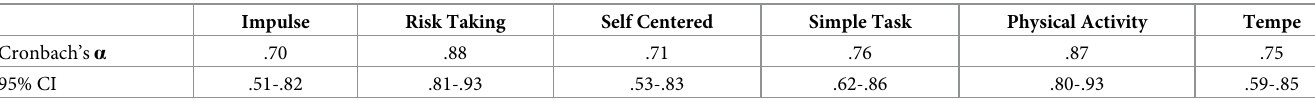
Table 3. Cronbach’s α for the six subscales of the self control